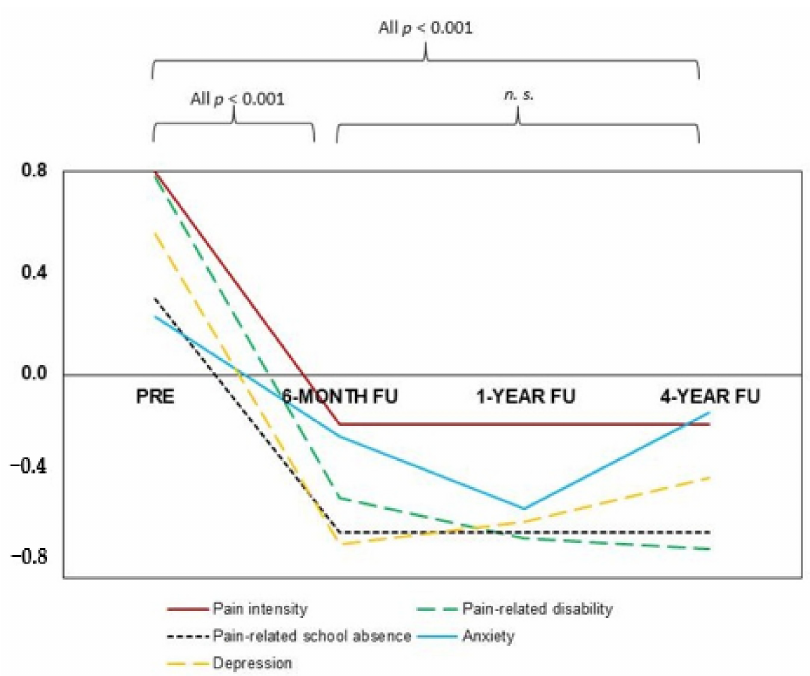
Figure 2. Z-standardized medians for the three pain-related and the two psychological measures at admission and the three follow-ups. The medians are standardized across all time